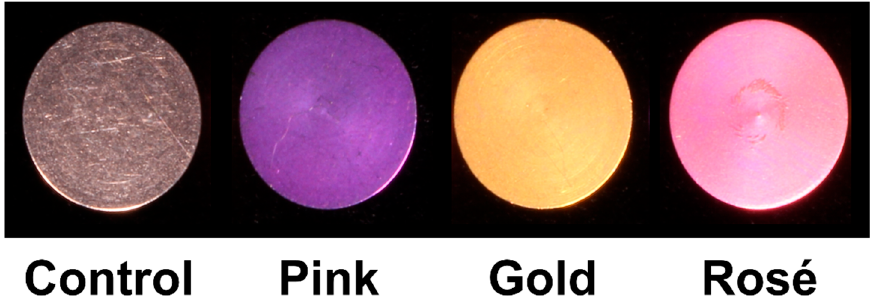
Figure 1. The di ff erent plates used in the Figure 1. The different plates used in the study.